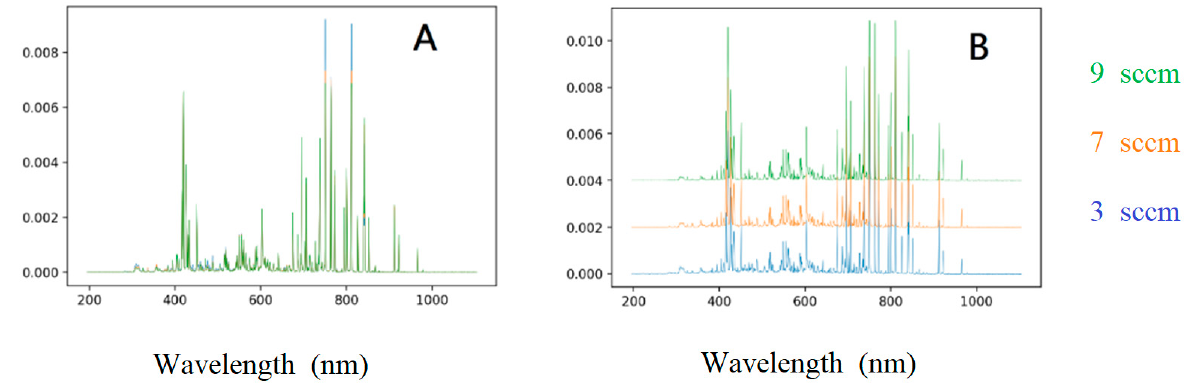
Figure 10. ( A ) Overlay of spectral data at 9, 7, and 3 sccm. ( B ) Segregation of the spectra.